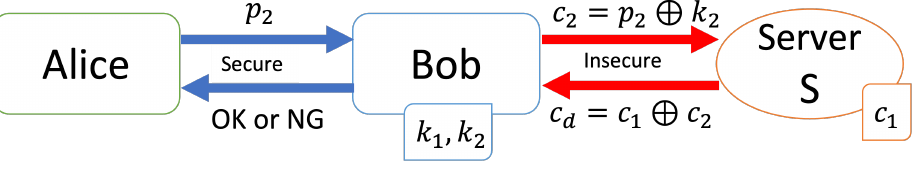
Figure 4. Verification step with the one-time